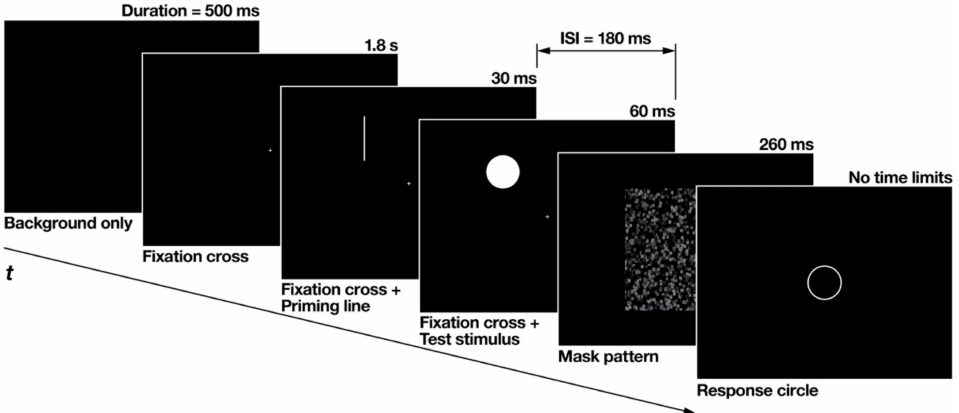
Figure 3. Flow of each experimental trial made from snapshots of the actual experiment displays. The thickness of the priming line and the response circle was enhanced for clearer definition. ISI is an abbreviation for inter-stimulus